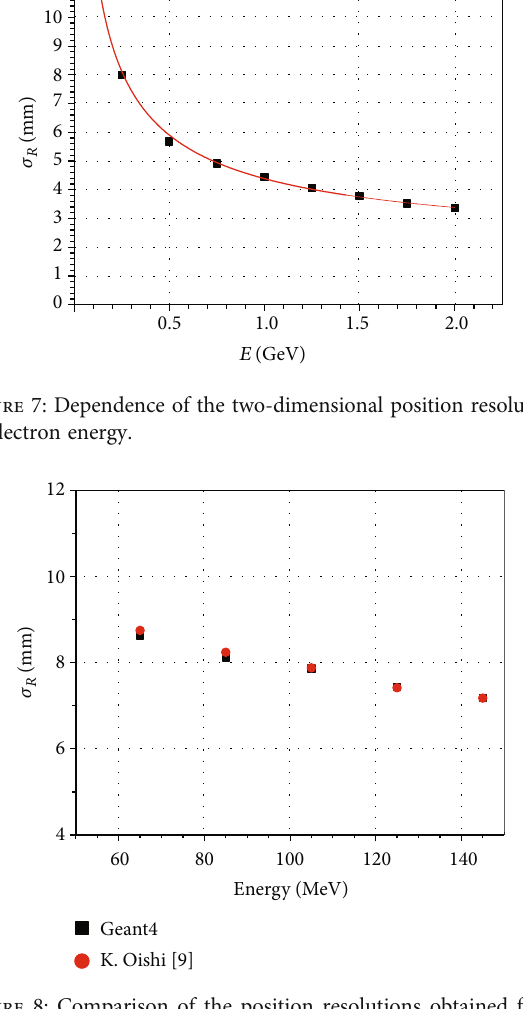
Figure 8: Comparison of the position resolutions obtained from Ref. [9] with Geant4 simulation for the 7 × 7 crystal